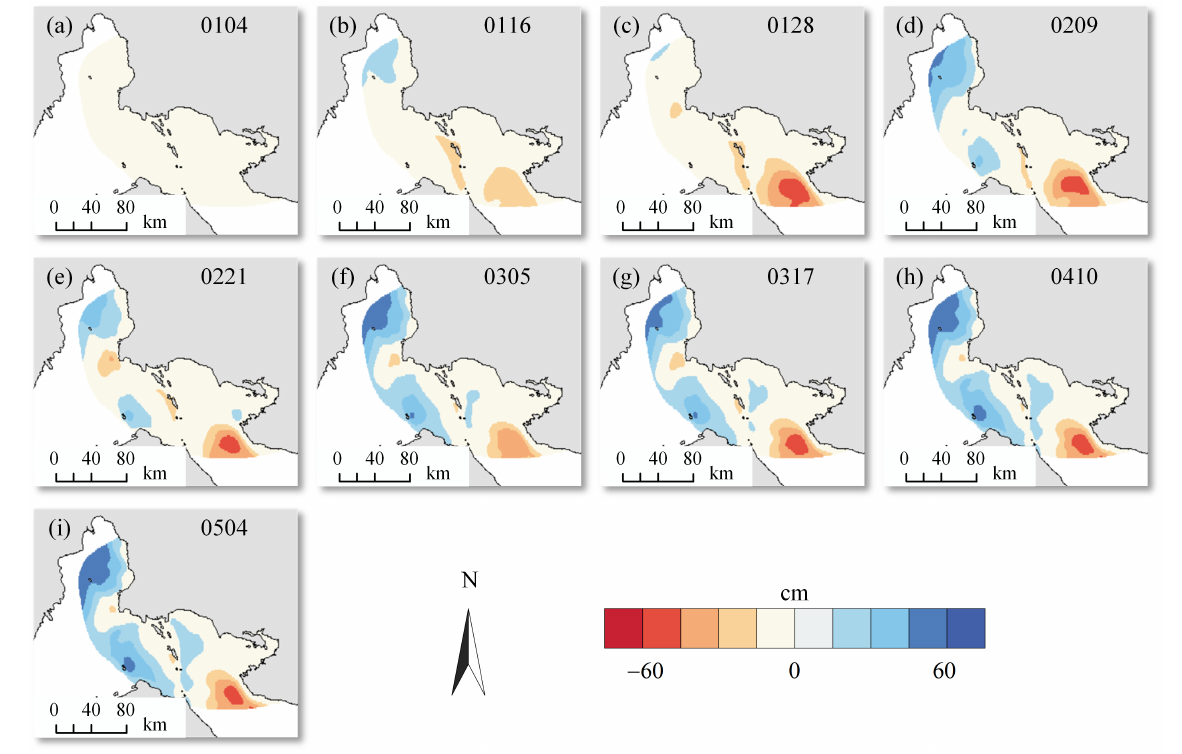
Figure 6. Retrieved time-series horizontal deformation from January 2019 to May 2019: the top-right number of subfigures ( a – i ) represents the corresponding SAR images acquisition dates.